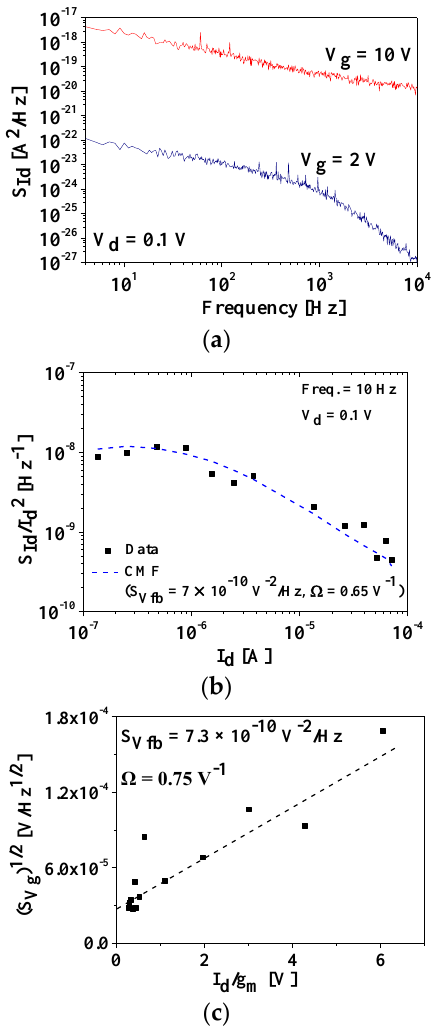
Figure 3. ( a ) Noise spectral density (S Id ) versus frequency at V g = 2 V and 10 V. ( b ) Normalized S Id (black square) versus I d matching with the correlated mobility fluctuations (CMF) noise model and ( c ) variation of the gate voltage noise spectral density (S Vg ) 1/2 as a function of (I d /g m ) in the fabricated GaN metal-insulator-semiconductor field-effect transistor (MISFET), measured at V d = 0.1 V and f = 10 Hz. The dashed line in ( b ) indicates the fitting line.